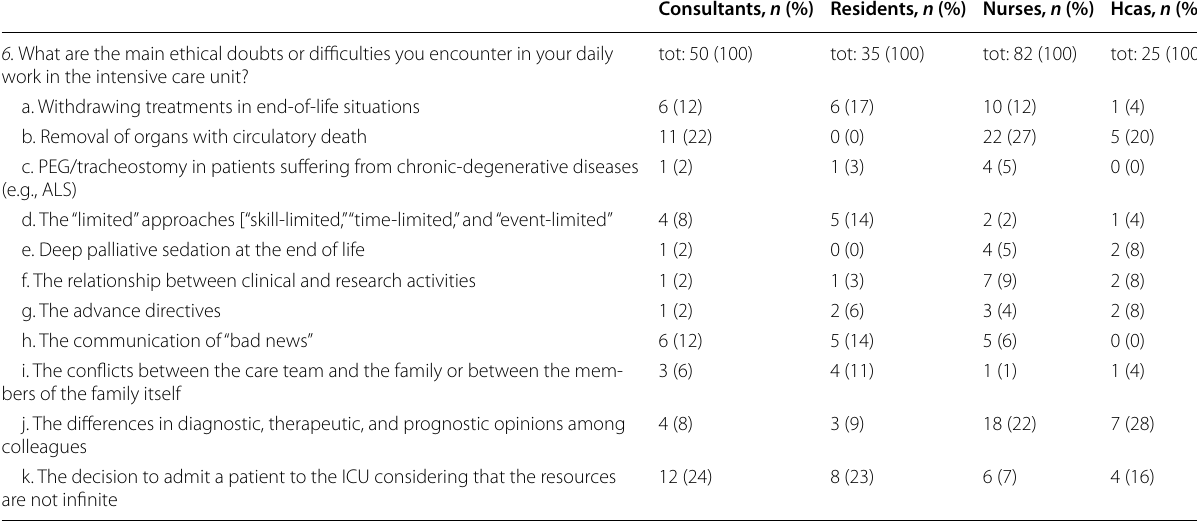
PEG percutaneous endoscopic gastrostomy, ALS amyotrophic lateral sclerosis, ICU intensive care